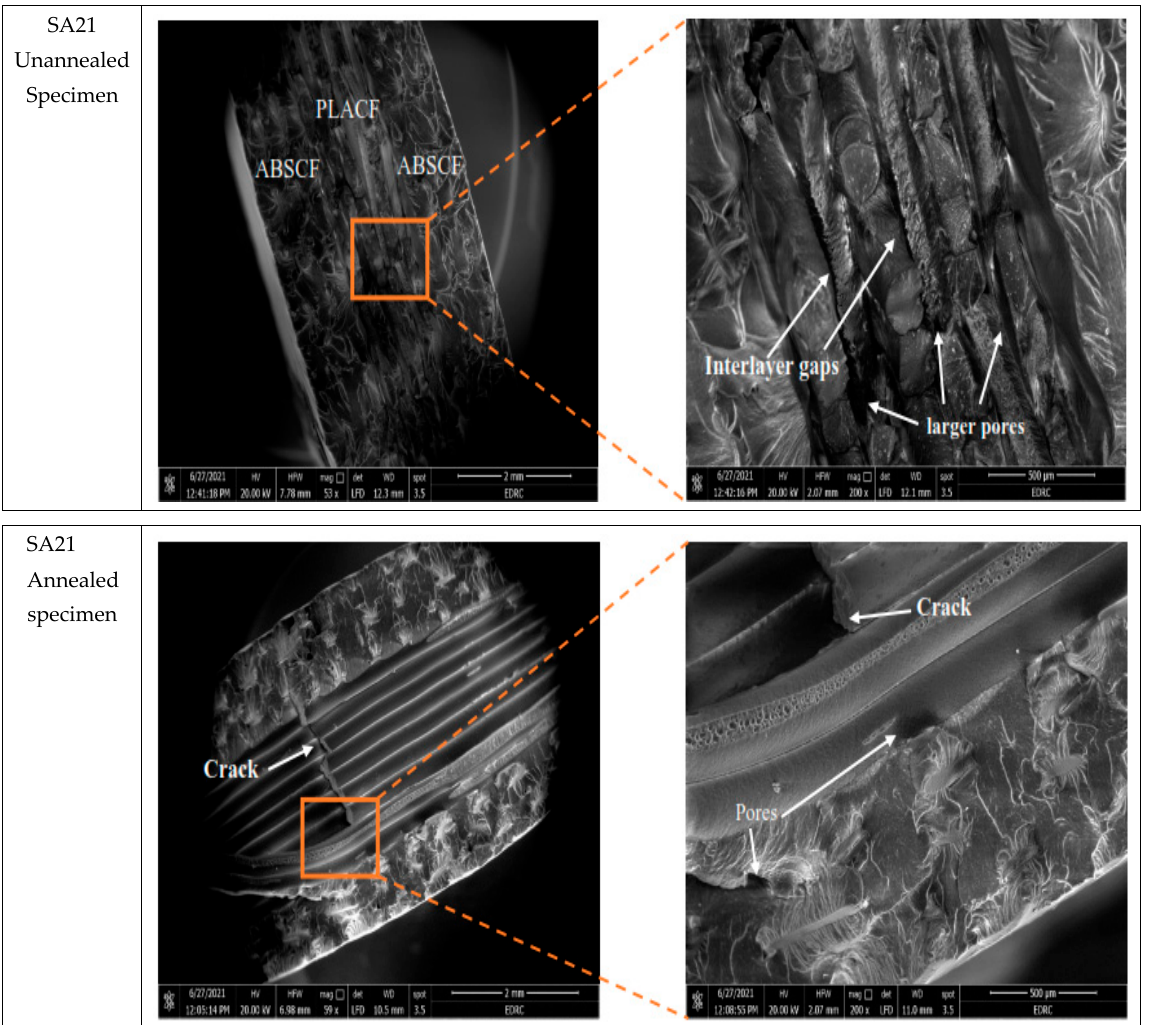
Figure 8. SEM photos and EDS plot of the effect of heat treatment over PP11 sample.